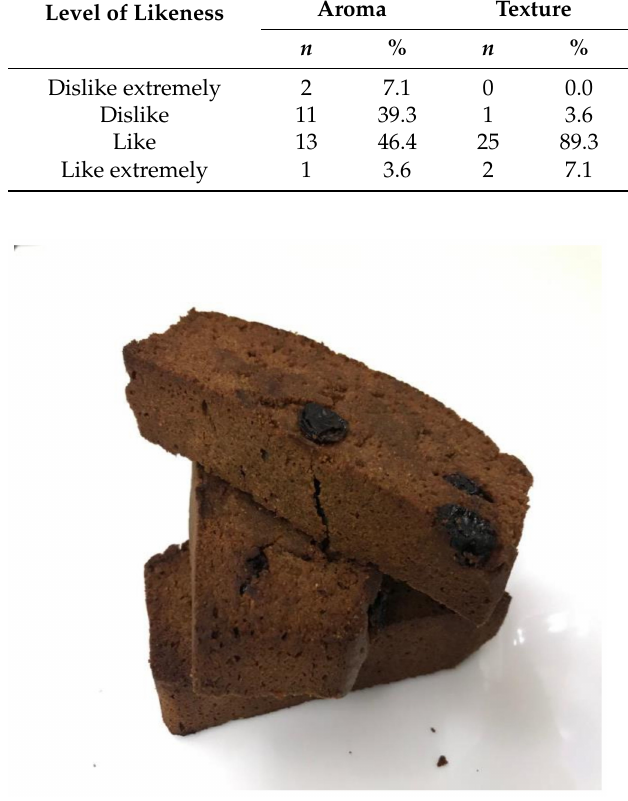
Figure 2. Broccoli-soybean-mangrove food bar ( Bruguiera gymnorrhiza ). Table 2. The hedonic quality